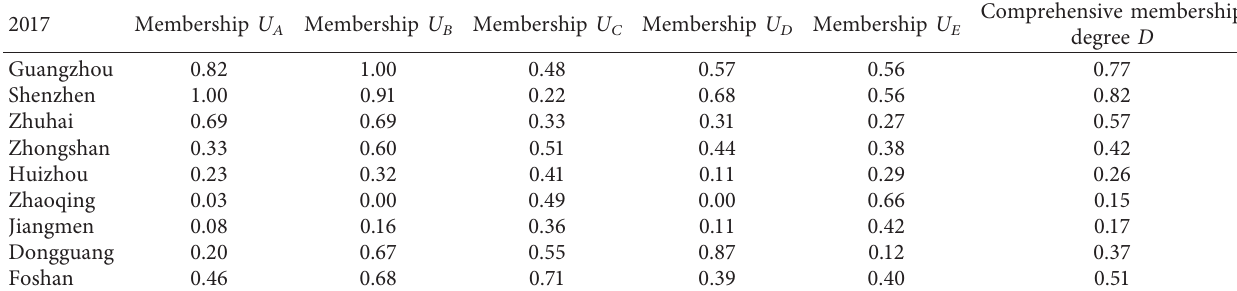
Table 16: First-level membership of the happiness index of nine cities in the Pearl River Delta in 2017.